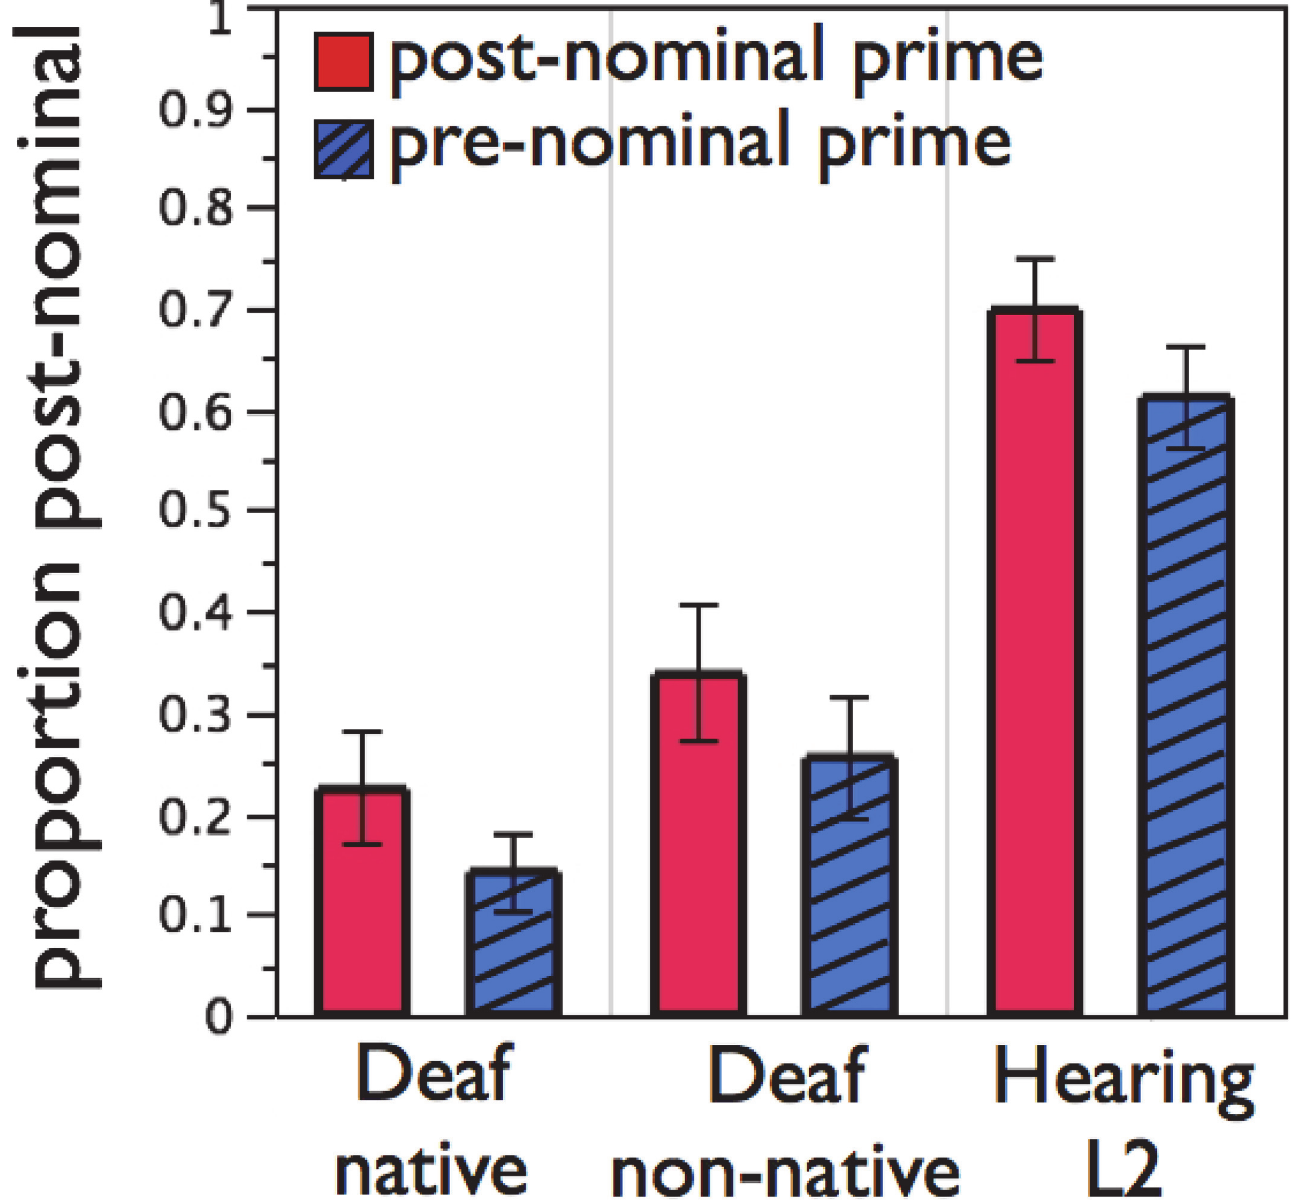
Fig 3. Equivalent syntactic priming across groups. Signers in each population produce more post-nominal descriptions after post-nominal primes (plain bars) than after pre-nominal primes (hashed bars). Error bars represent SEM.